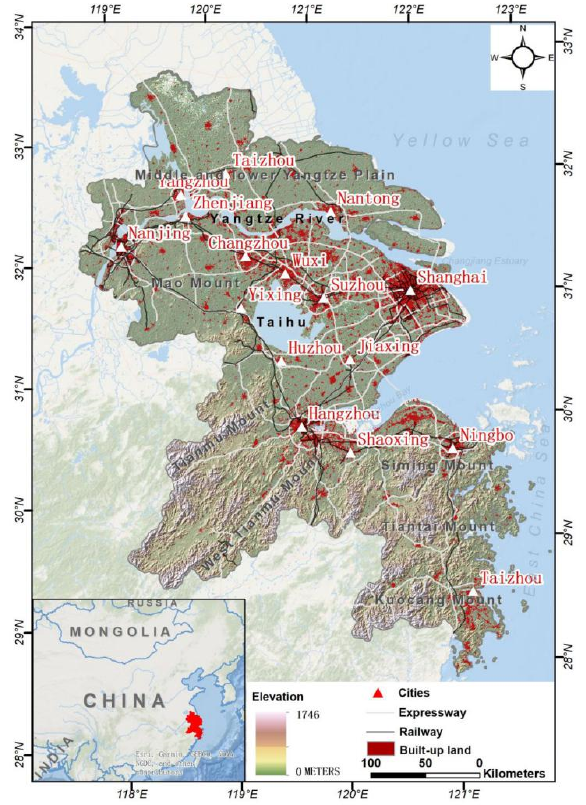
Figure 1. Location map of the study area.